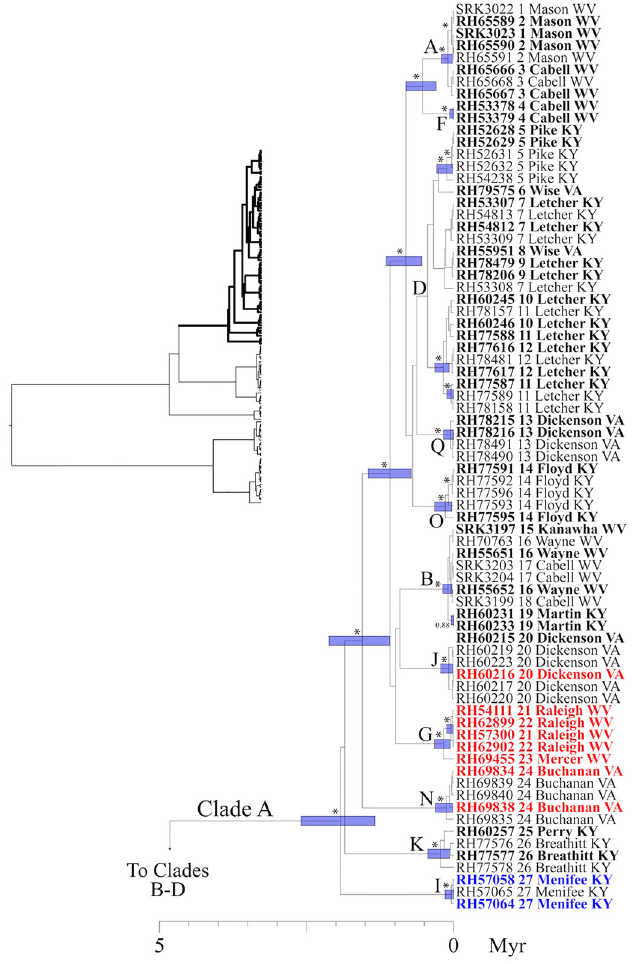
Fig 3. Bayesian maximum clade credibility tree. This phylogeny was inferred using concatenated mtDNA data (Cyt- b , ND2, tRNA trp , tRNA ala ). Taxon labels include specimen identification number, the population numbers from Fig 1, and county plus state information. Numbers adjacent to nodes are posterior probabilities (pp), and asterisks identify nodes with pp (cid:1) 0.95. Bars indicate 95% confidence intervals (CI) for dates of nodes. For visual clarity, many pp values and CI bars were removed near the tips of the tree. Specimens in the "complete" data set, which includes five nuclear loci in addition to mtDNA, are highlighted in bold. The bGMYC analysis delimited either 17 putative species, or two putative species, depending on the probability threshold employed (see text). The 17 putative species are identified using the letters (A-Q) adjacent to nodes; the two putative species are represented by Clade A, and Clades B-C. Finally, three putative species delimited in the Geneland analysis are highlighted using colored text that is either black (species A), red (species B), or blue (species C). Clade A is here illustrated. The entire phylogeny is illustrated in the upper left, with Clade A illustrated using bold lines. See Fig 4 for Clades